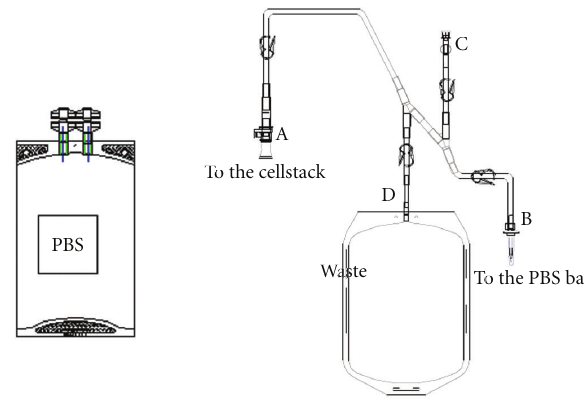
Figure 2: Set of tubing plus phosphate-bu ff ered saline and waste bag for medium exchange.